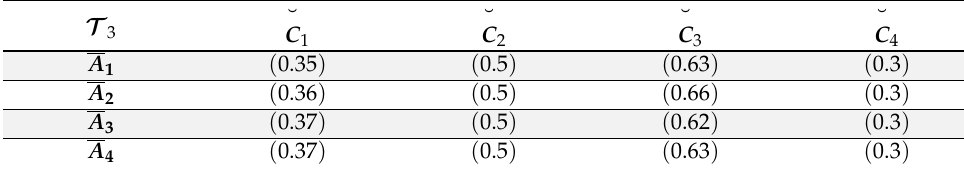
Table 9. Decision matrix, which calculates the value of T 3 .